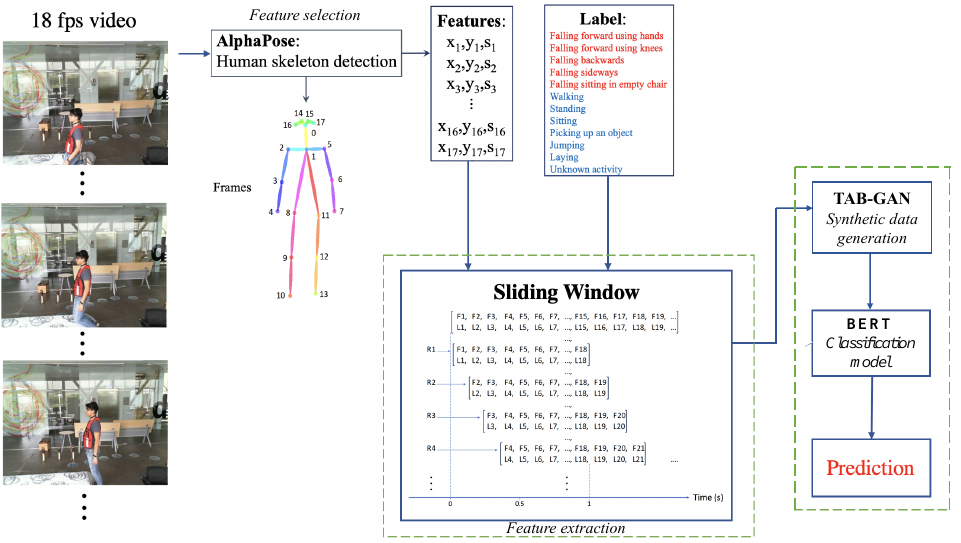
Figure 1. Workflow for activity